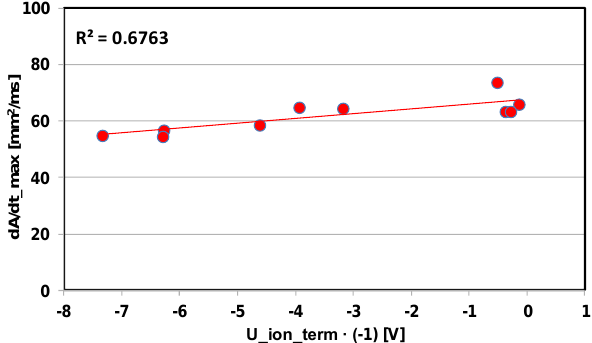
Fig. 9. Correlation between the value of flame propagation speed in the cylinder and the maximum value of chemical ionization voltage